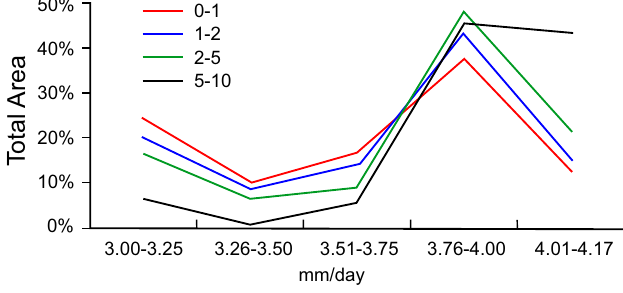
Figure 8. Percentage area of rain rate average. The color lines represent critical cohesion predicted by SHALSTAB using TRMM rainfall along the rainfall classes.